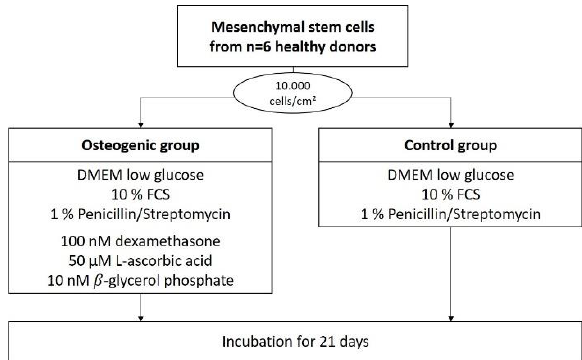
Figure 8. Flow chart for the differentiation of hMSCs.